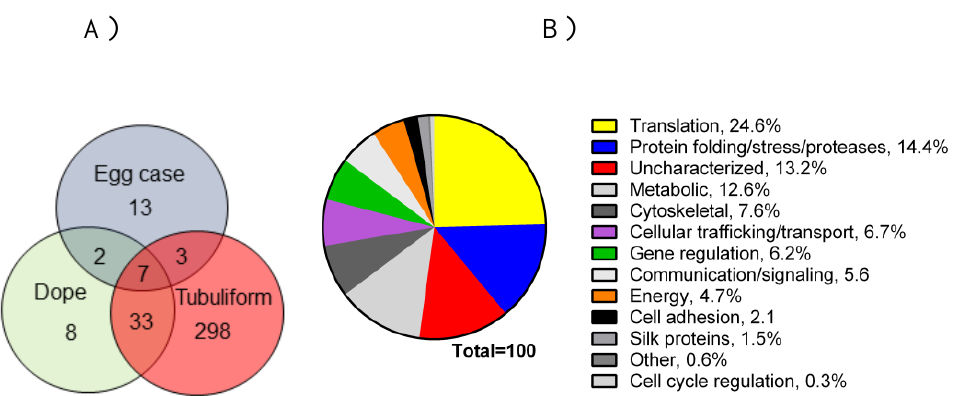
Figure 3. Venn diagram representing number of proteins expressed in tubuliform glands, liquid spinning dope, and egg sacs, along with a pie chart of percentages of proteins expressed in the tubuliform gland categorized into several different molecular and cellular functions: ( A ) Venn diagram; ( B ) pie chart.